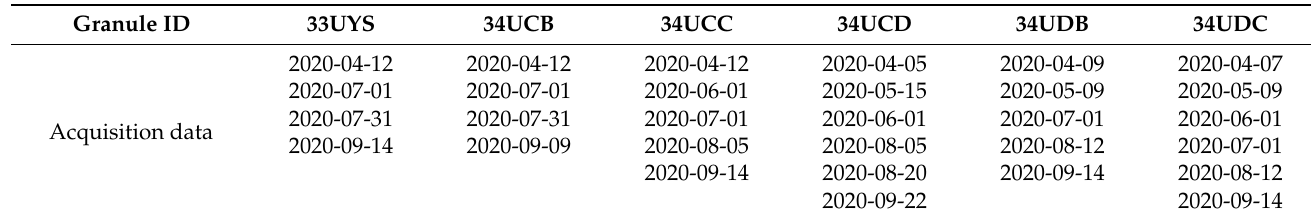
Table 1. A set of Sentinel-2 data used in the classification